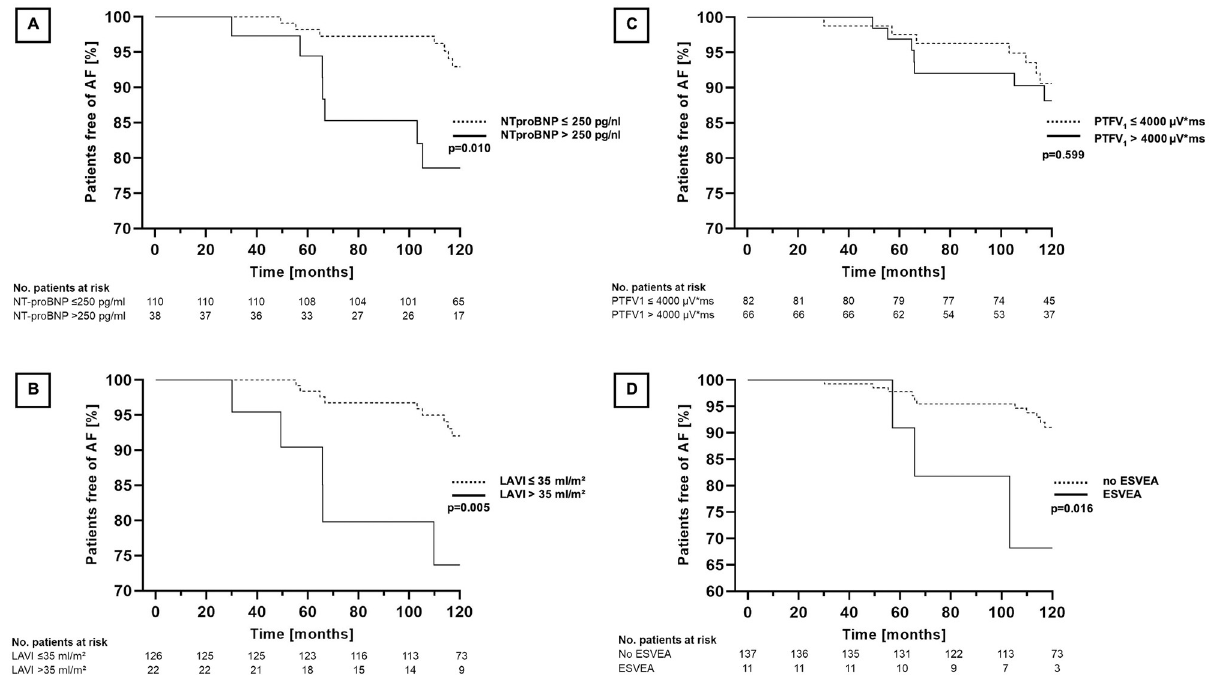
Fig 3. Kaplan-Meier curves of AF-free survival for the different parameters of left atrial disease. (A) AF-free survival in patients with NT-proBNP � 250 pg/ml and > 250 pg/ml. (B) AF-free survival in patients with LAVI � 35 ml/m 2 and > 35 ml/m 2 . (C) AF-free survival in patients with PTFV1 > 4000 μ V � ms and PTFV1 � 4000 μ V � ms. (D) AF-free survival in patients with ESVEA and no ESVEA. AF = Atrial fibrillation; LAVI = Left atrial volume index; ESVEA = Excessive supraventricular ectopic activity.